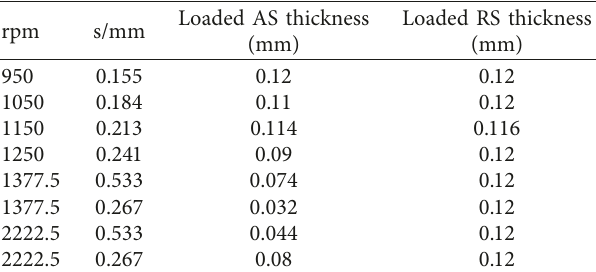
Figure 4: Vickers microhardness measurement results. Table 12: Minimum hook distances measured on advancing (AS) and retreating